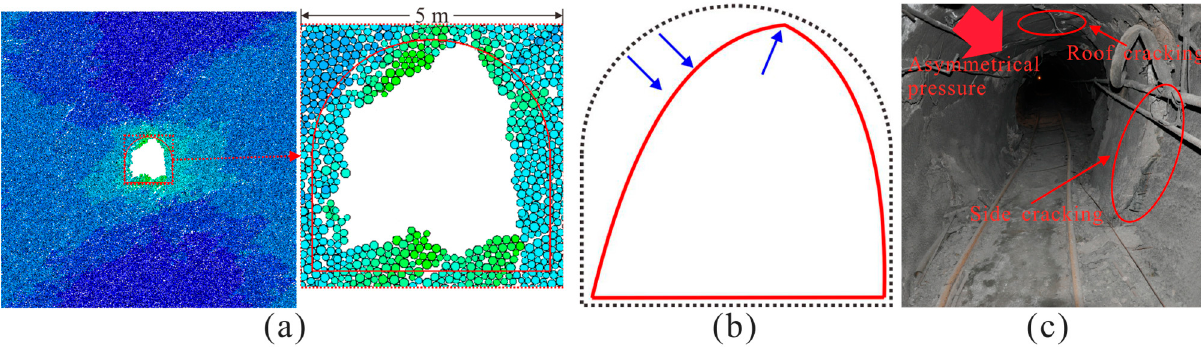
representation. ( c ) Field